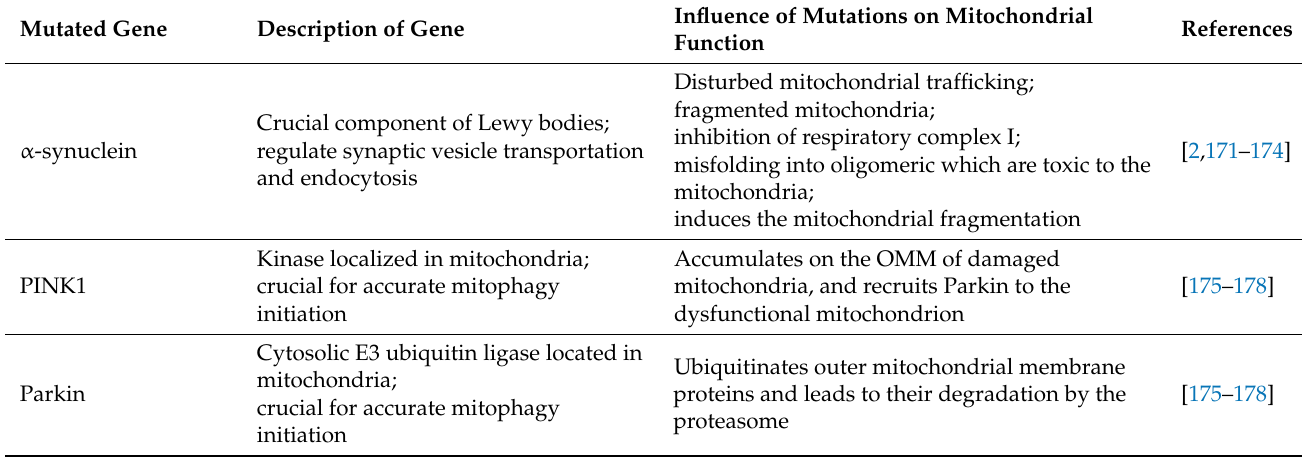
Table 2. The summary of PD-involved genes and their influence on mitochondrial functions. Mutated